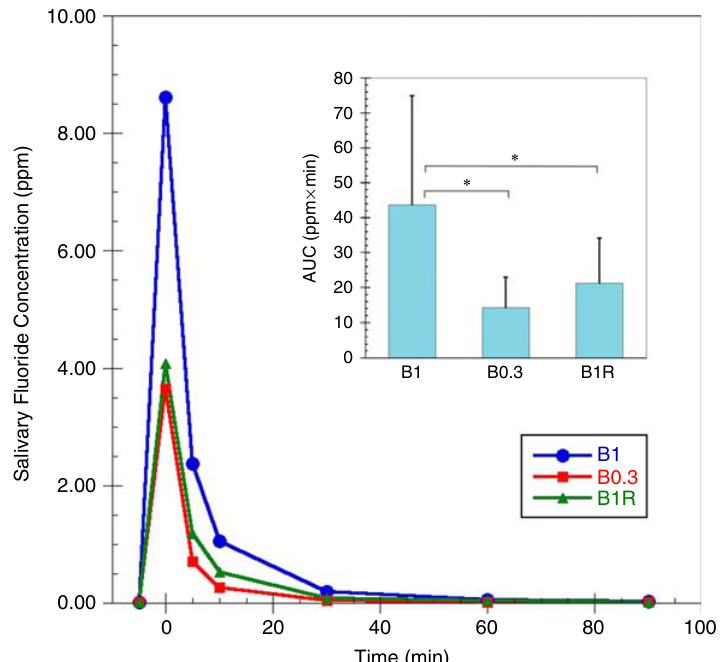
Figure 2. Mean salivary fluoride concentration decreased with time after brushing with 1,000 ppm F toothpaste and following post- brushing rinse procedures; B1 and B0.3 (brushing with 1 g and 0.3 g toothpaste without rinsing, respectively) and B1R (brushing with 1 g toothpaste then rinsing with 5 ml water for 10